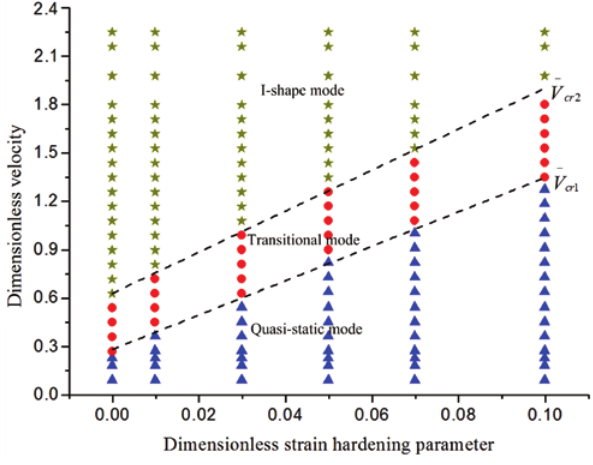
Figure 4: Deformation map of closed-cell foams with strain